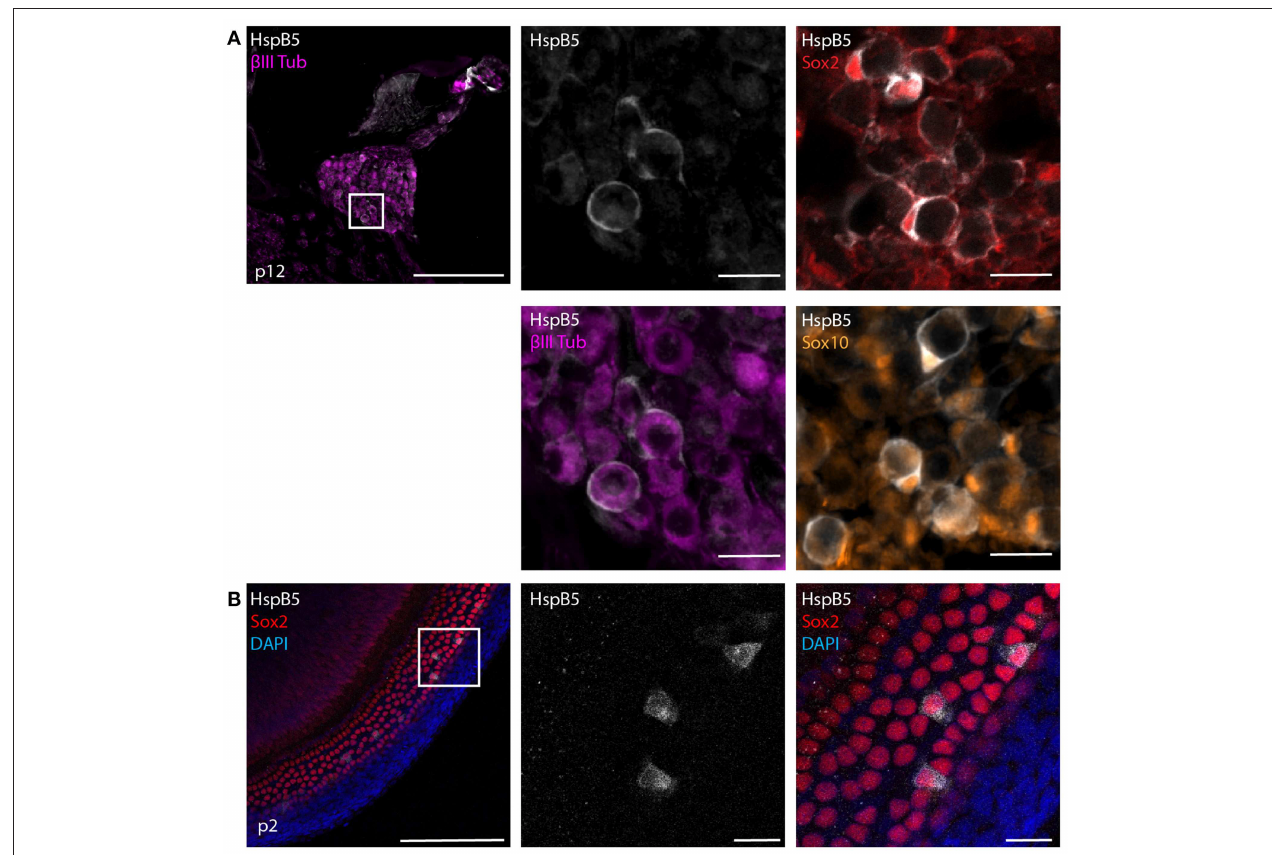
FIGURE 2 | Endogenous expression of HspB5. (A) Immunostaining of mid-modiolar cryosection stained for HspB5 (white) and the Schwann cells markers Sox2 + (red) and Sox10 + (orange) or the neuronal marker β III Tubulin (magenta) in p12 rats. (B) Immunostaining of organ of Corti whole mounts of p2 animals for HspB5 (white) and the supporting cells marker Sox2 (red). Scale bars in overview images indicate 200 µ m while scale bars of magnified areas represent 20 µ m. 4 weeks post infection compared to the mock-infected controls ( p < 0.0001) ( Figure 4C